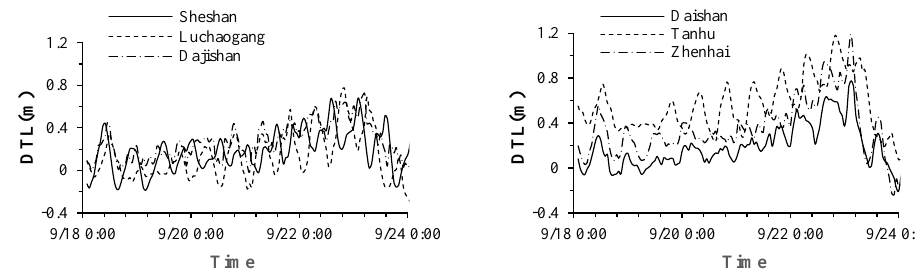
Figure 5. Difference in tidal level (DTL) between measured tide and computed astronomical tide at the six stations.